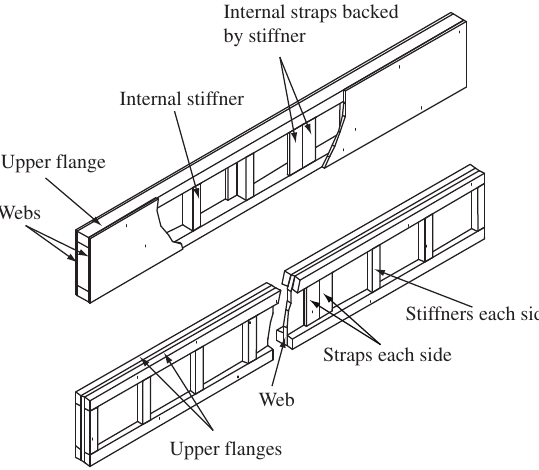
Figure 1. Scheme of Plywood timber beams with box and “I”